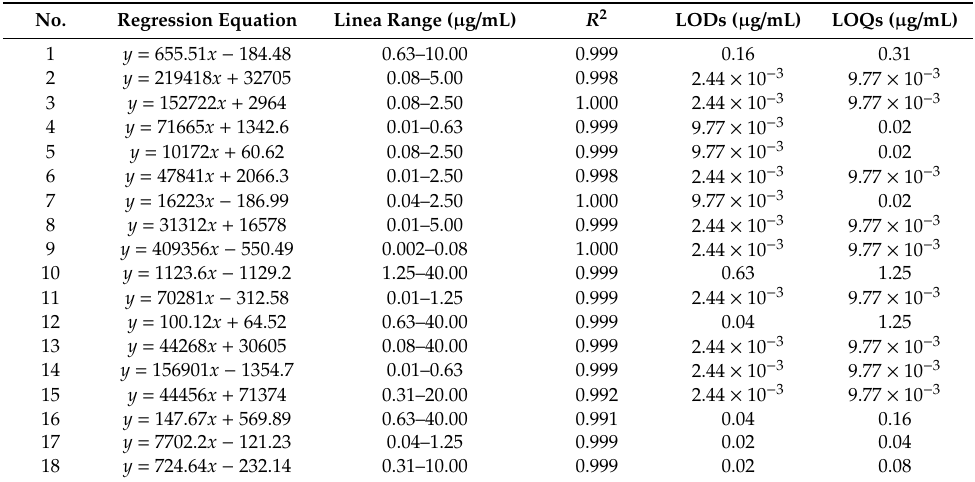
Table 2. Summary of calibration results, limit of detection (LOD), and limit of quantification (LOQ)